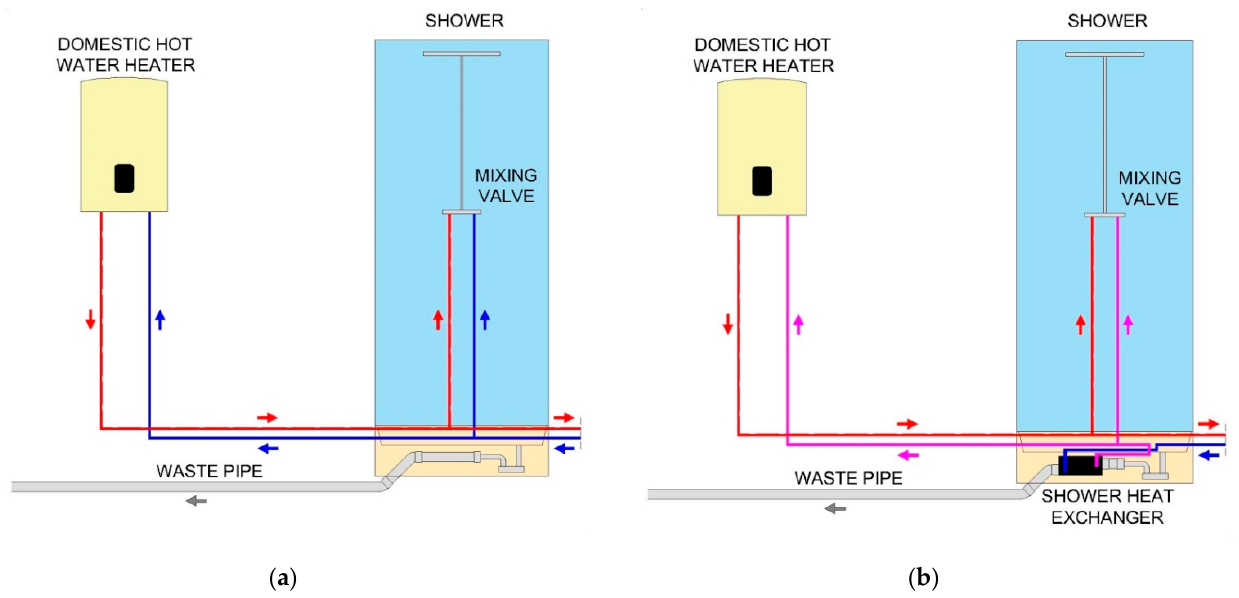
Figure 4. Shower installation diagram: ( a ) without the compact DWHR unit; ( b ) with the compact DWHR unit.